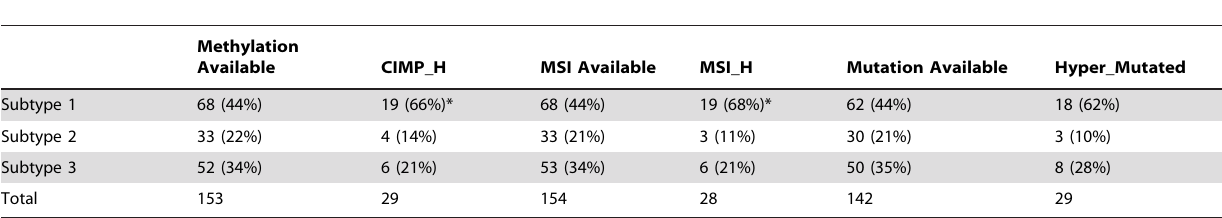
Table 2. Overlap between our subtypes and TCGA CIMP_H, MSI and Hypermuated annotations.